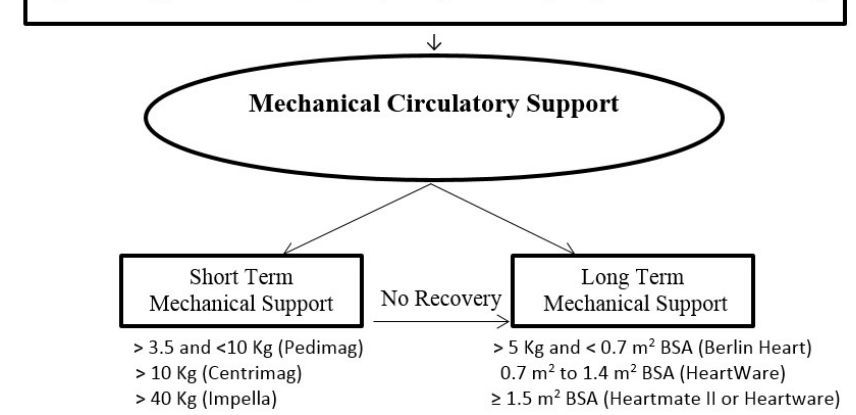
Figure 5. Indication of mechanical circulatory support and device selection in children with heart failure. (BSA = body surface area, IV = intravenous).